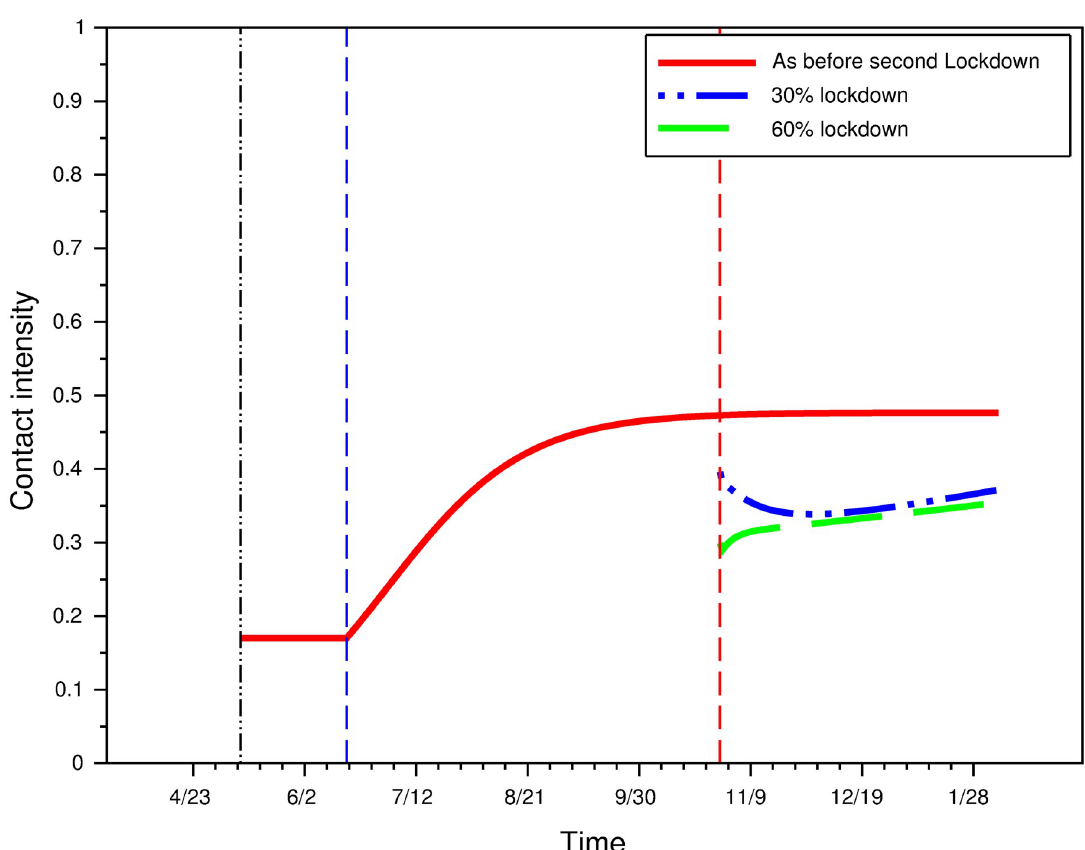
Fig 12. Impact of 30% and 60% partial lockdown on contact intensity.